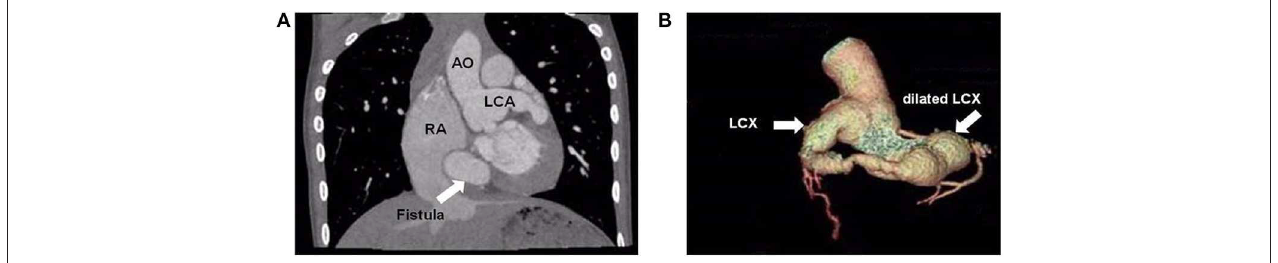
FIGURE 3 | Cardiac computed tomographic view the dilated left main coronary artery and circumflex artery. (A) Cardiac computed controlled X-ray shows dilated left main coronary artery and right atrium. The arrow points to the fistula. (B) Three-dimensional reconstructed computed tomographic demonstrates the dilated left